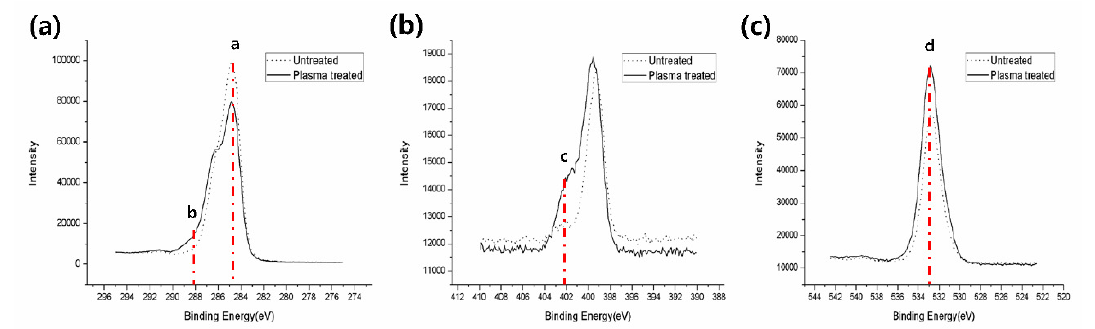
Figure 6. The surface chemical composition of the epoxy resin analyzed by X-ray Photoelectron Spectroscopy before and after the non-thermal atmospheric pressure nitrogen plasma treatment.